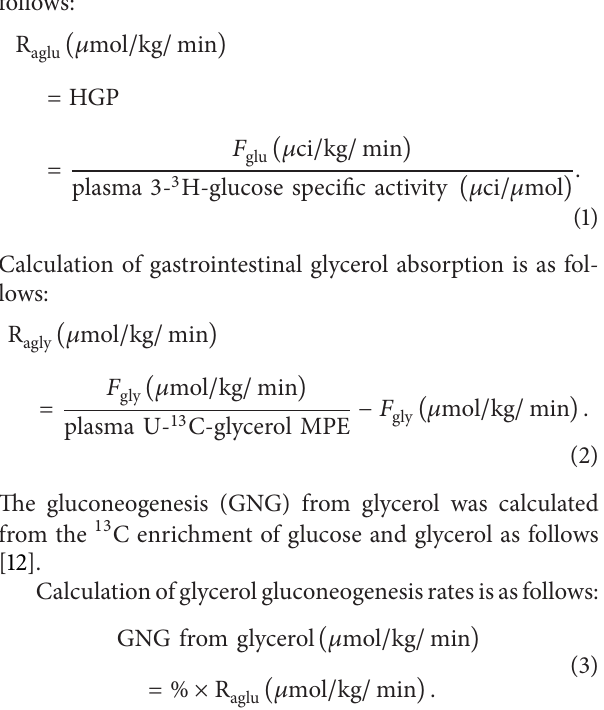
mass-to-charge ratios ( m/z ) of 218 (unlabeled glycerol) and 221 (labeled glycerol) were selectively monitored. The peak area ratio 221/218 was calculated, and the corresponding enrichment (MPE) was determined from standard curves containing weighted amounts of natural and U- 13 C-glycerol and injected before and after biological samples. Similarly, ions with mass-to-charge ratios ( m/z ) of 319 (unlabeled glu- cose) and 322 (labeled 1,2,3- 13 C-glucose) were also selectively monitored. The peak area ratio 322/319 was calculated, and the corresponding enrichment was